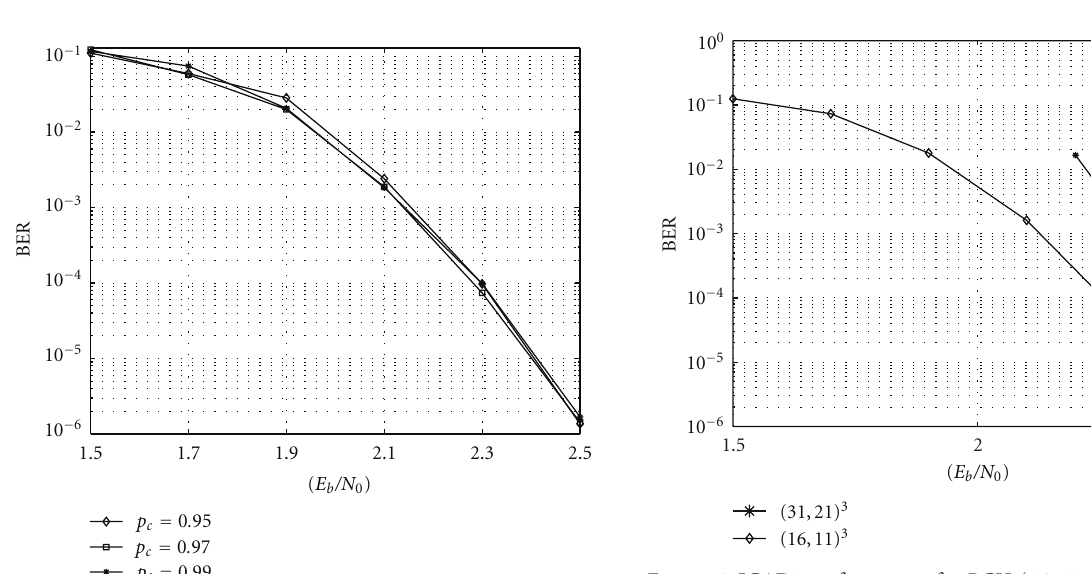
Figure 9: IGAD1 performances for BCH (16, 11, 4) 3 and BCH (31, 21, 4) 3 3D-PBC PBC at 12th